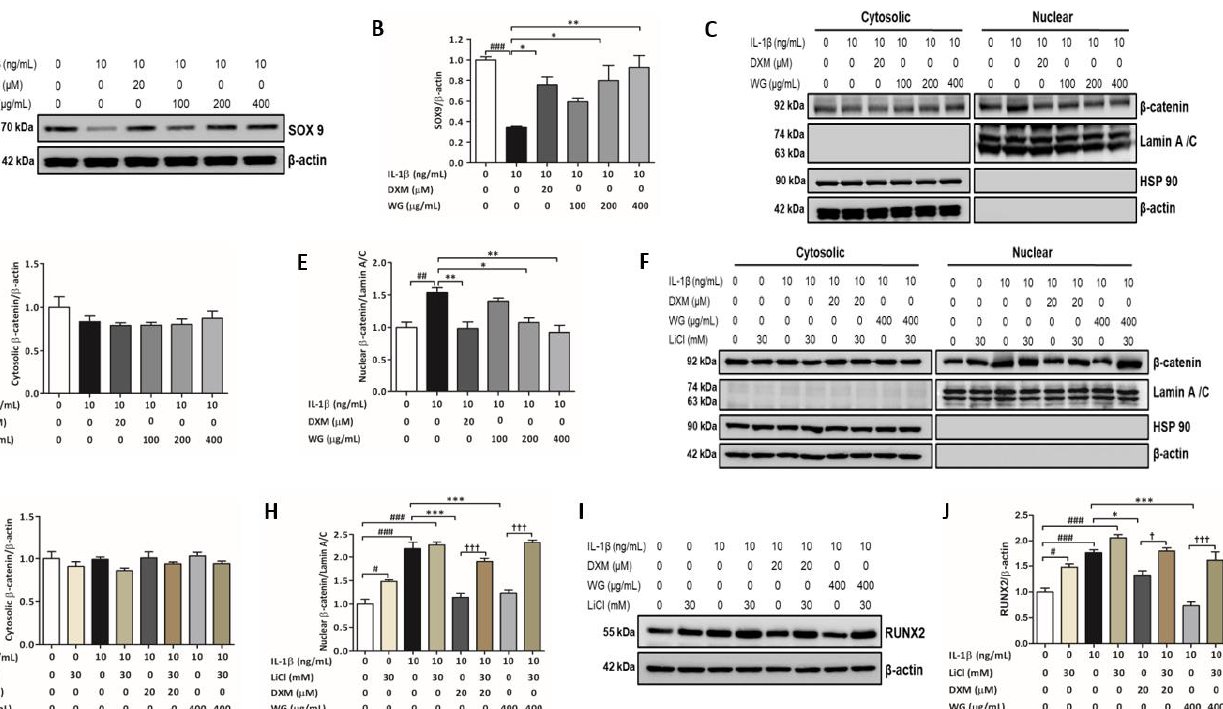
Figure 5. WG increased SOX9 expression and attenuated the IL- 1β - induced β -catenin signaling pathway. ( A ) Western blot analysis of SOX9. ( B ) Quantitative analysis of SOX9 relative to β -actin. ( C ) Western blot analysis of cytosolic and nuclear and fractions using β -catenin antibody, quantitative analysis of (D) cytosolic β -catenin relative to β -actin and (E) nuclear β -catenin relative to Lamin A/C. SW1353 cells were pre-treated with indicated concentration of WG or DXM for 4 h in 0.2% BSA media followed by IL- 1β for 24 h. ( F ) Western blot analysis of cytosolic and nuclear and fractions using β -catenin antibody, quantitative analysis of (G) cytosolic β -catenin relative to β -actin and (H) nuclear β -catenin relative to Lamin A/C. ( I ) Western blot analysis of RUNX2, ( J ) quantitative analysis of RUNX2 relative to β -actin. SW1353 cells were pre-treated with WG or DXM for 4 h in 0.2% BSA media followed by IL- 1β for 24 h in the presence or absence of LiCl. Data shown represent mean ± SEM ( n = 3). (# p < 0.05, ## p < 0.01 and ### p < 0.001 vs. control; * p < 0.05, ** p < 0.01, and *** p < 0.001 vs. IL- 1β; † p < 0.05 and ††† p < 0.001 vs. DXM or WG).